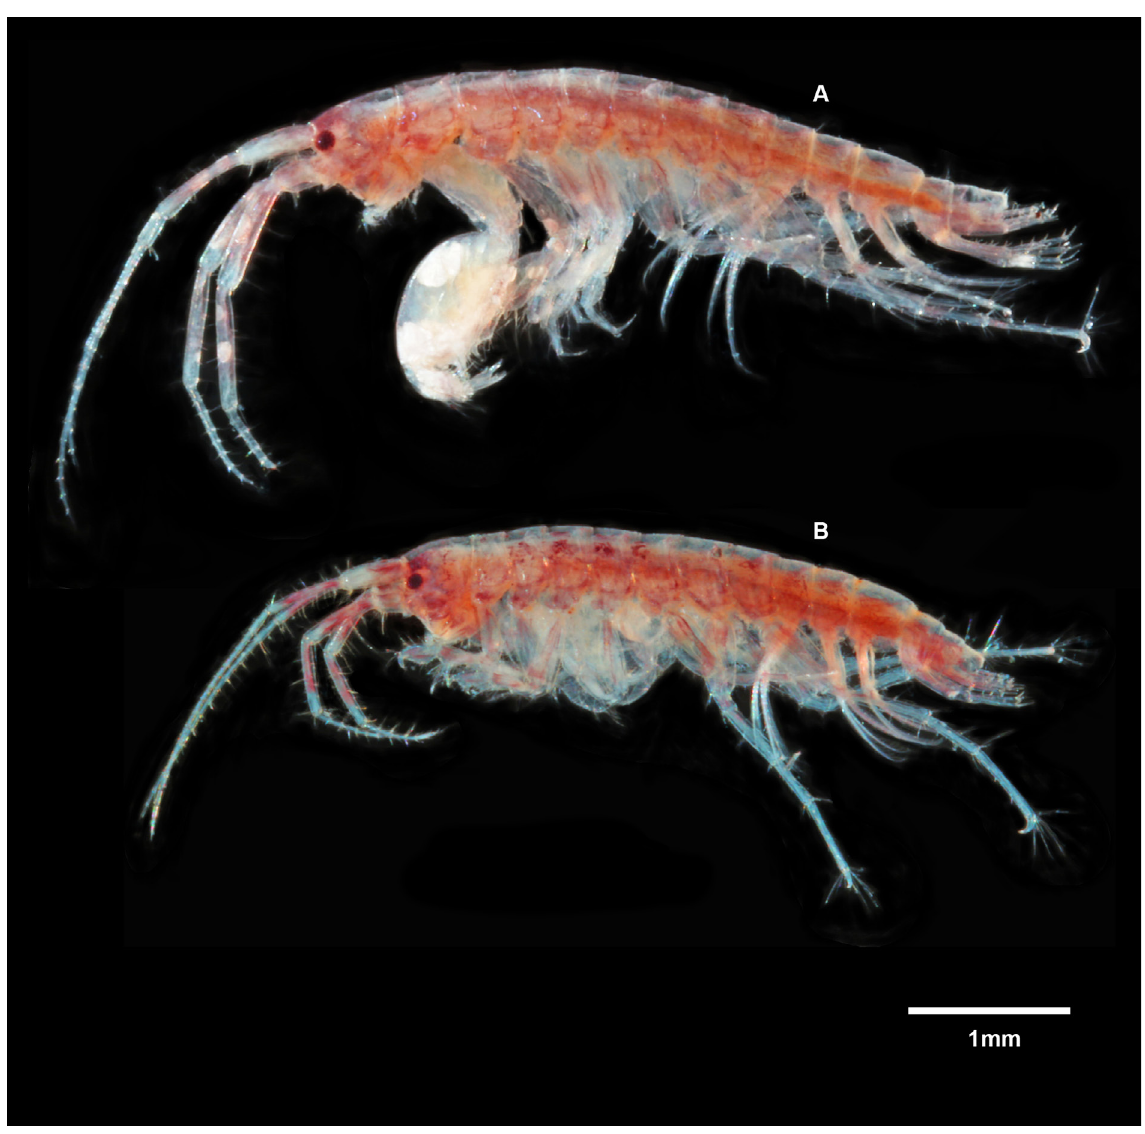
Fig. 2. Grandidierella pawaiensis sp. nov. A . Holotype, ♂, lateral view (ZRC 2018.0493). B . Allotype, ♀, lateral view (ZRC